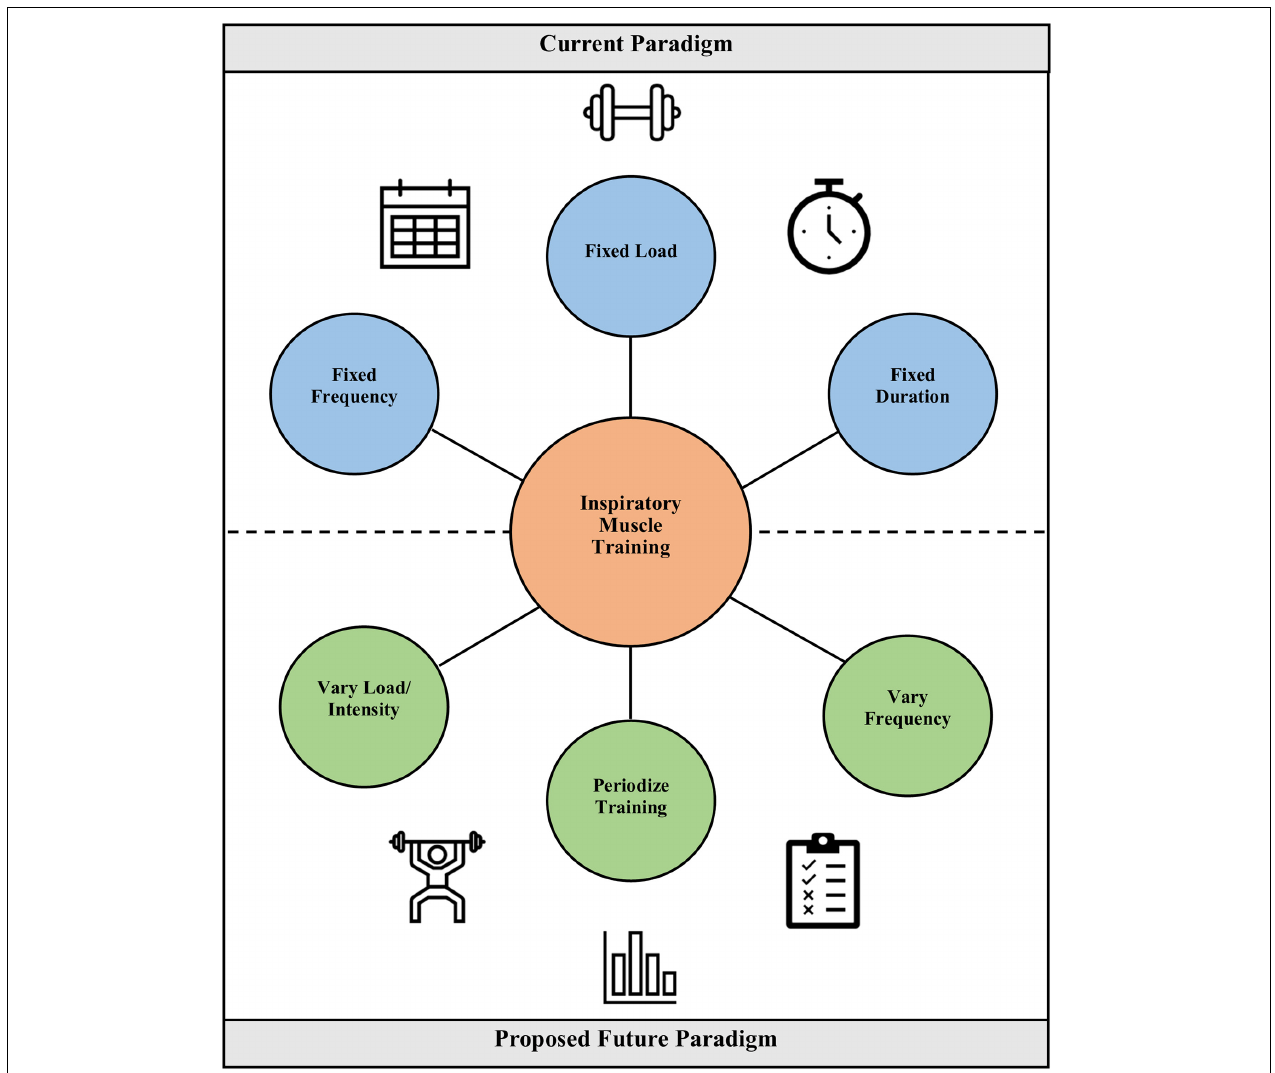
FIGURE 2 | Comparison of the current paradigm for IMT prescription vs. a proposed future paradigm in which load and intensity are varied, training is periodized, and frequency is varied. The latter constitutes a more individualized training prescription akin to how sport coaches prescribe training to their